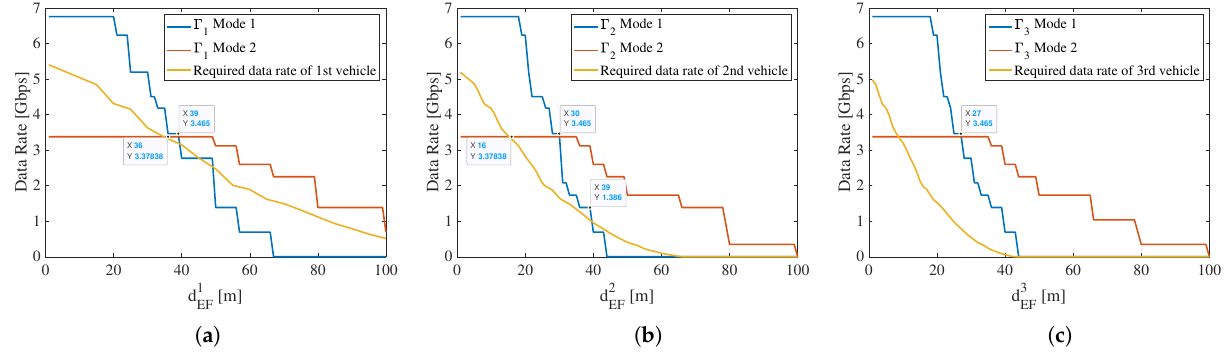
Figure 7. Comparison between achievable E2E throughput (Modes 1 and 2) and required data rate ( G t = G r = 30 dBi, p Mode1 = − 11 dBm, p Mode2 = 4 dBm, B = 2.16 GHz, d n vehicle; ( b ) second vehicle; ( c ) third